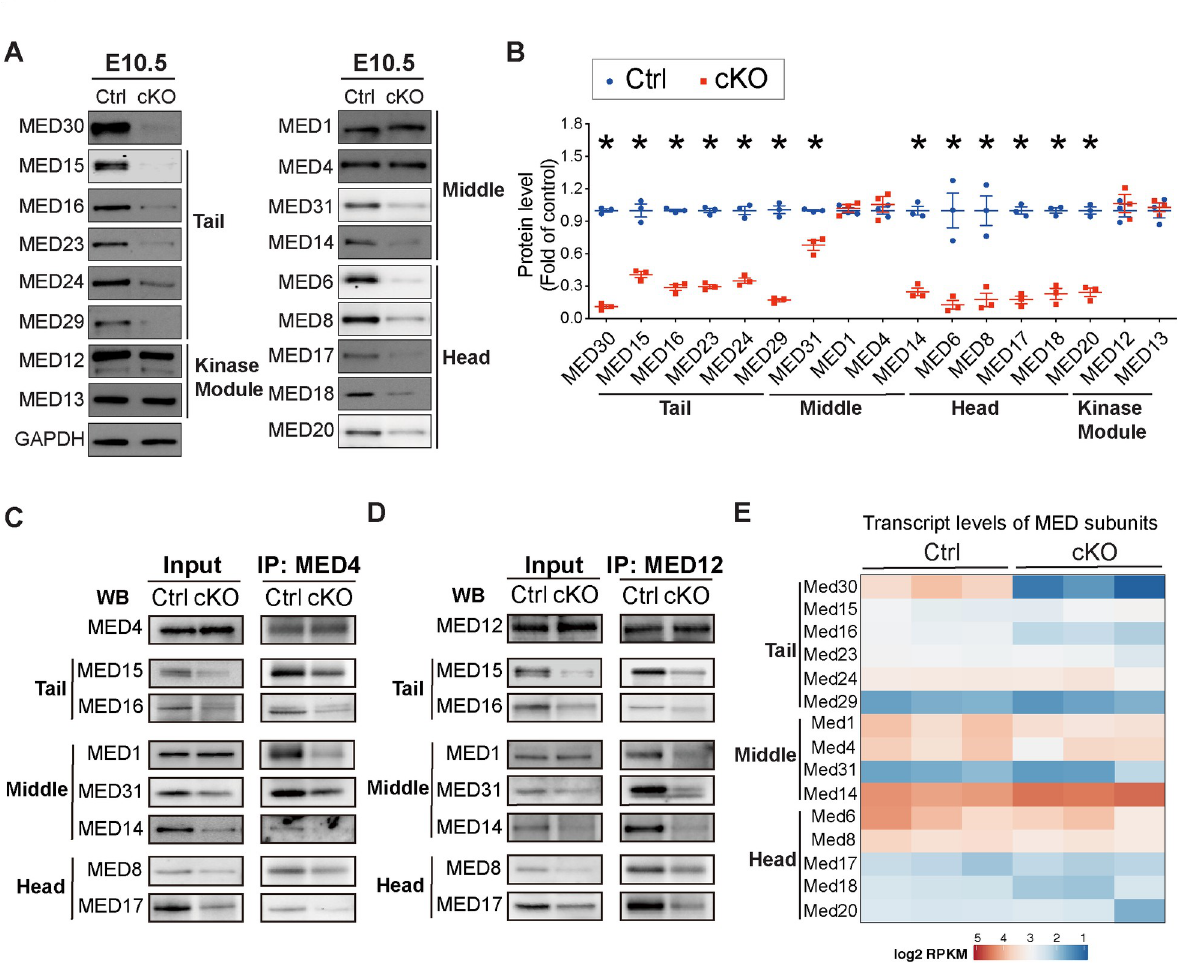
Fig 2. Loss of MED30 results in degradation of Mediator core in developing cardiomyocytes. (A-B) Representative immunoblots (A) and quantification analysis (B) of MED30 and MED Tail submodule subunits MED15, MED16, MED23, MED24 and MED29; MED Middle submodule subunits MED1, MED4, MED31 and MED14; MED Head submodule subunits MED6, MED8, MED17, MED18 and MED20, and Kinase module subunits MED12 and MED13 in hearts isolated from Med30 cKO and control (Ctrl) embryos at E10.5. GAPDH served as a loading control. n = 3. (C-D) Co-Immunoprecipitation (Co-IP) of E10.5 heart lysates with antibody to MED4 (C) or MED12 (D), followed by Western blot (WB) analysis for MED subunits. 40 hearts from each genotypes were pooled for one IP experiment. (E) Heatmap representation of transcript levels of selected Mediator subunits in Med30 cKO and Ctrl hears at E10.5. Data are represented as the mean ± SEM. � P < 0.05, by 2-tailed Student’s t test. western blot analysis to examine protein levels of Mediator subunits at E10.5. We examined representative subunits of each Mediator core submodule: MED15, MED16, MED23, MED24, MED29 within the Tail submodule; MED1, MED4, MED31, MED14 within the Middle sub- module; and MED6, MED8, MED17, MED18, MED20 within the Head submodule. We also